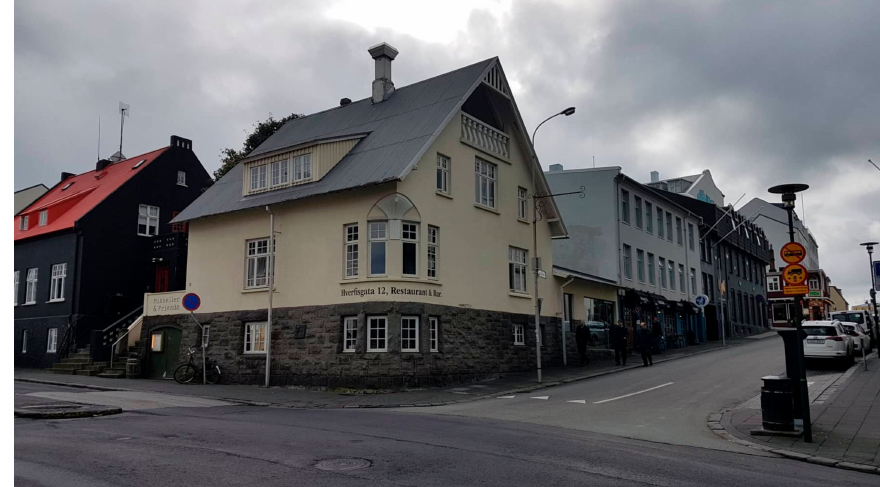
Figure 2. Guðmundur Hannesson’s house at Hverfisgata 12, Reykjav í k (Photo by Arl è ne Lucianaz, 2018. Imaged used with permission of the